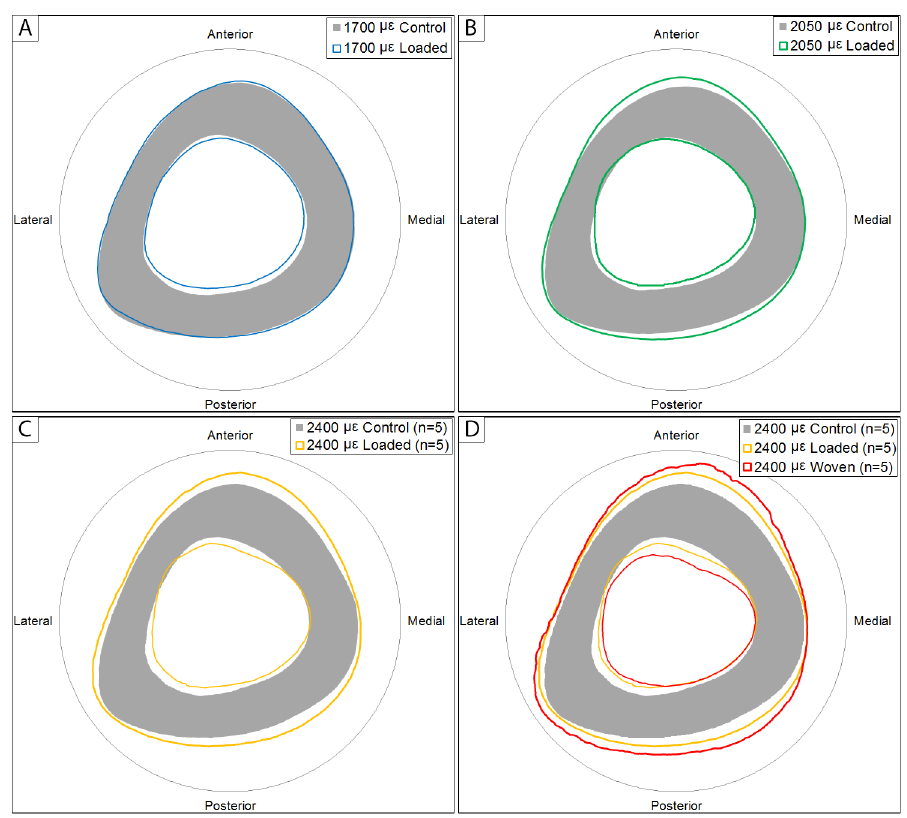
Fig 4. Schematic Representations of Standard Site Geometric Profiles. A) 1700 με group. B) 2050 με group. C) 2400 με group. There was a dose-dependent increase in cortical parameters with robust periosteal and endocortical formation, especially at the higher strain levels. D) 2400 με group with the addition of those animals that experiences a woven bone response due to